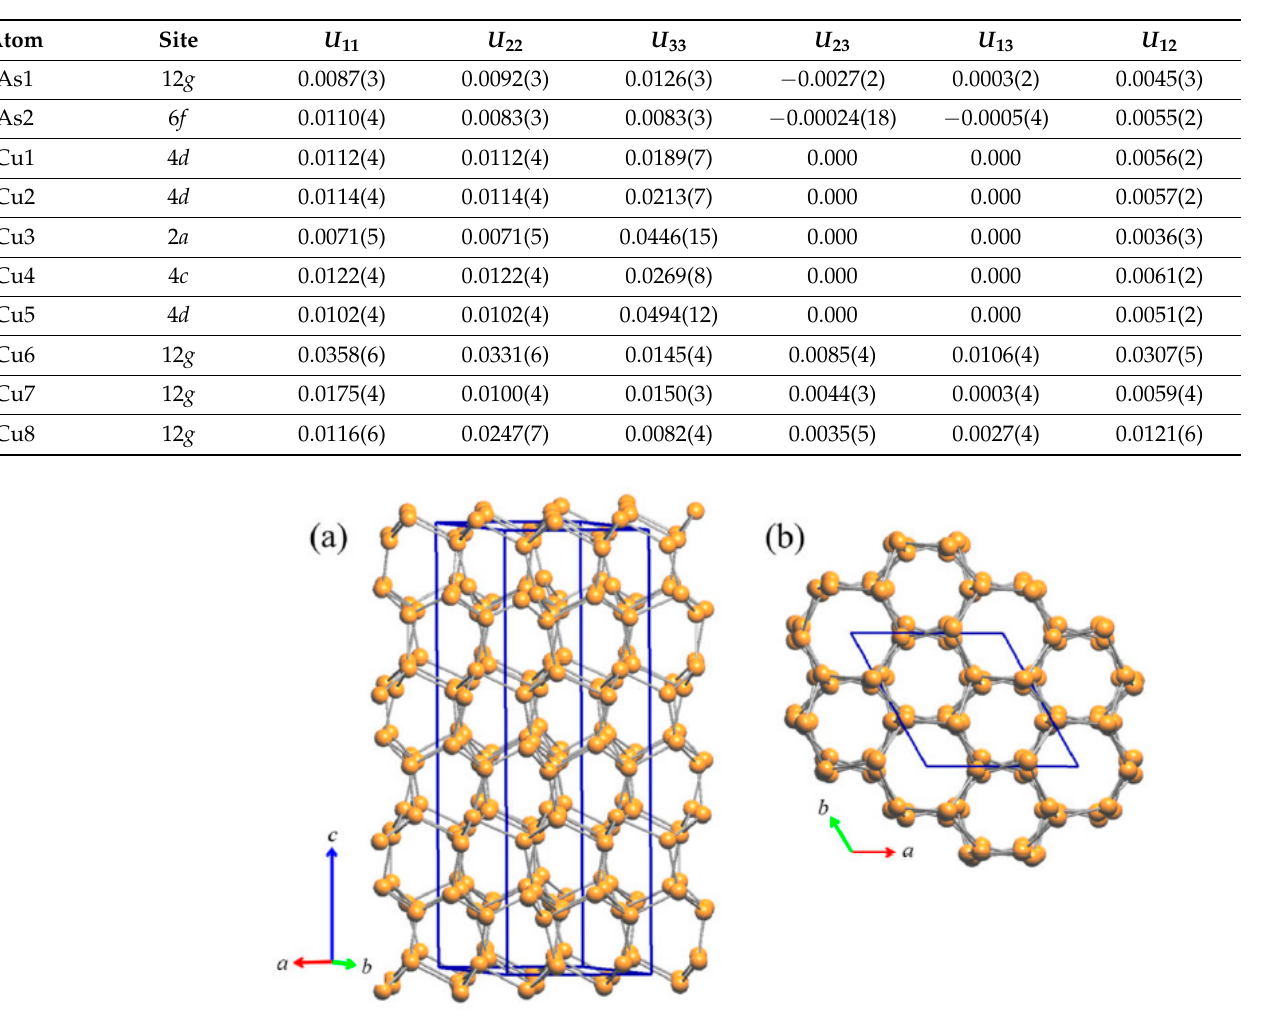
Figure 10. ( a ) Perspective and ( b ) top view of the lonsdaleite type network, which is also preserved in the LT structure of Cu 3 As; here, it is formed by Cu6, Cu7 and Cu8